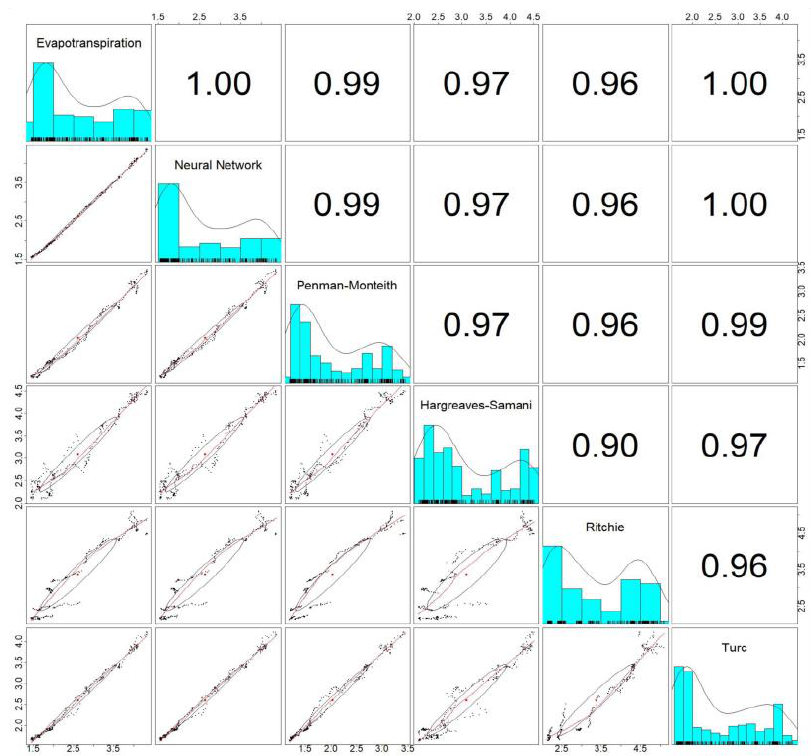
Figure 9. Comparison of the ETo as compared to the application of the Penman-Monteith, Hargreaves-Samani, Ritchie, and Turc equations.